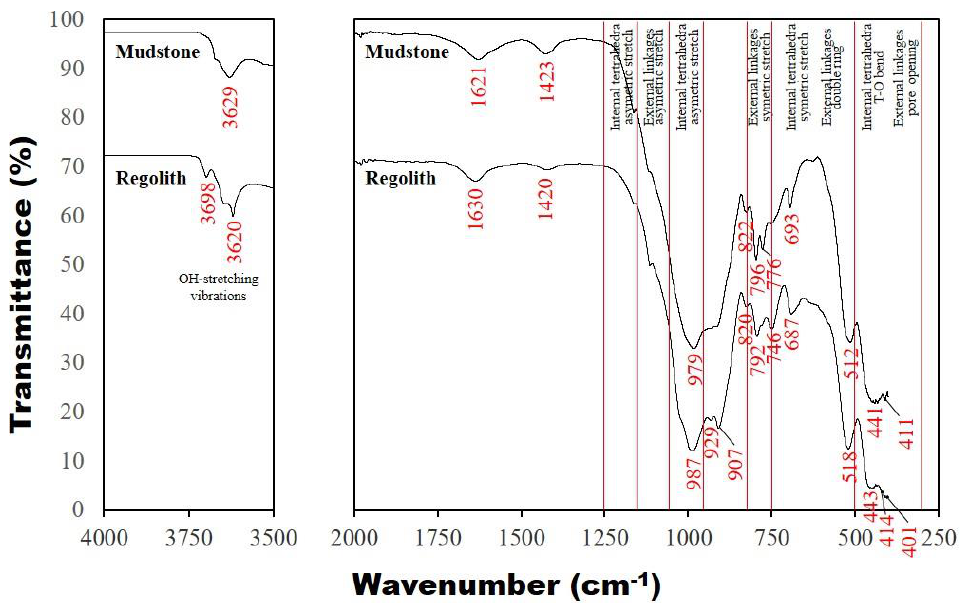
Figure 8. FTIR spectrum of the analyzed mudstone and regolith.